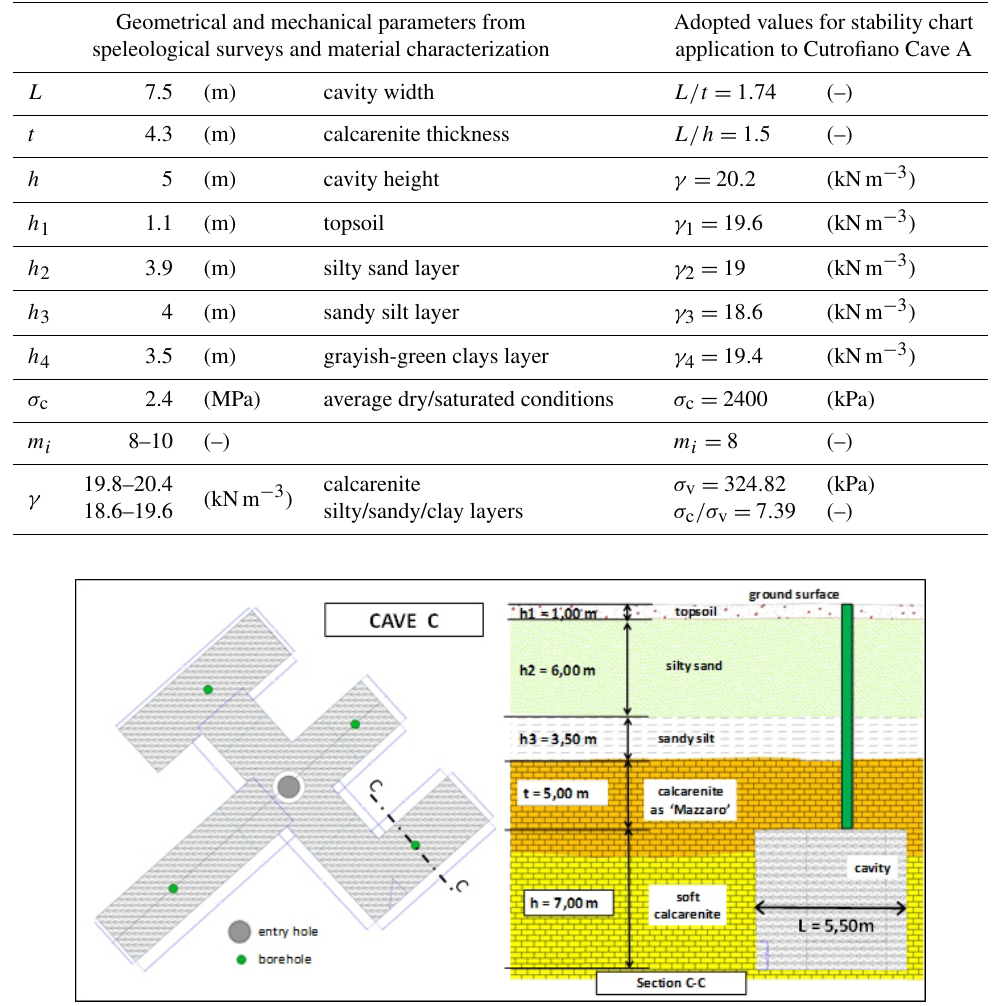
Table 5. Geometrical and mechanical parameters and adopted values for stability chart application to the underground Cutrofiano Cave A (Maglio and Ligori, 2014; Parise and Lollino, 2011).